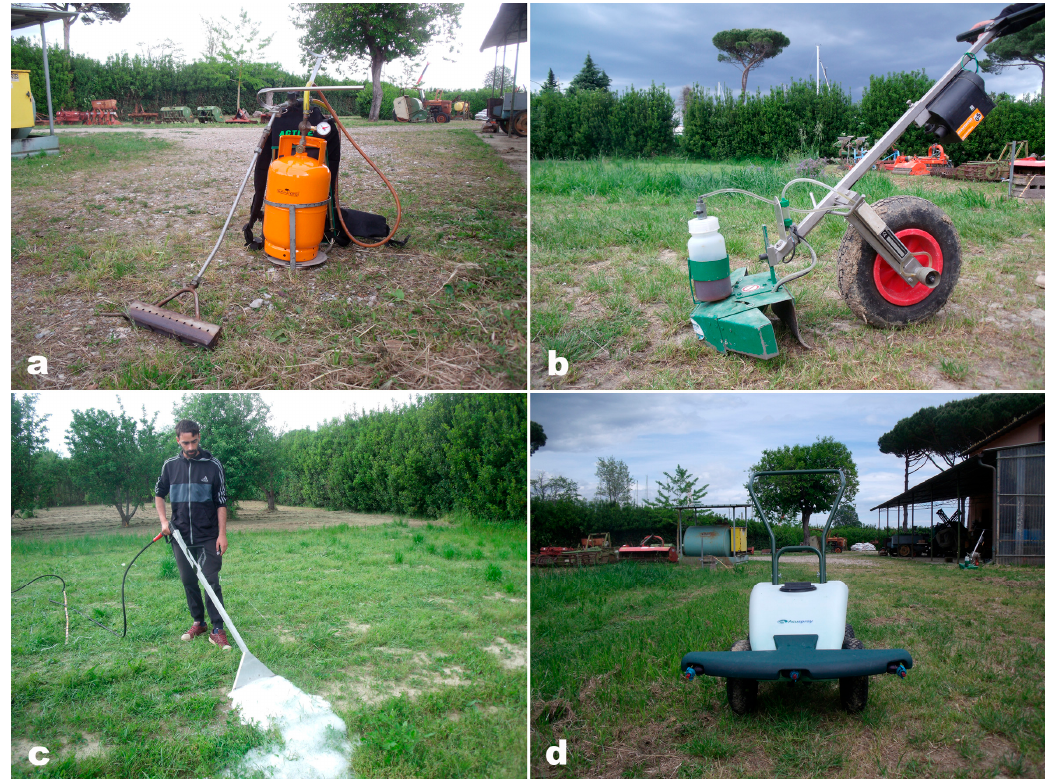
Figure 1. Machines used in the experiments for weed control: ( a ) prototype back-pack flaming machine; ( b ) ultra low volume sprayer (MANKAR-P 30–50 Flex, Mantis ULV ® , Geesthacht, Germany) used for glyphosate application; ( c ) hot foam distribution tool (Weedingtech Ltd., London, UK); ( d ) sprayer (Acuspray, Techneat engineering ltd, Ely, Cambridgeshire, UK) used for nonanoic acid distribution.